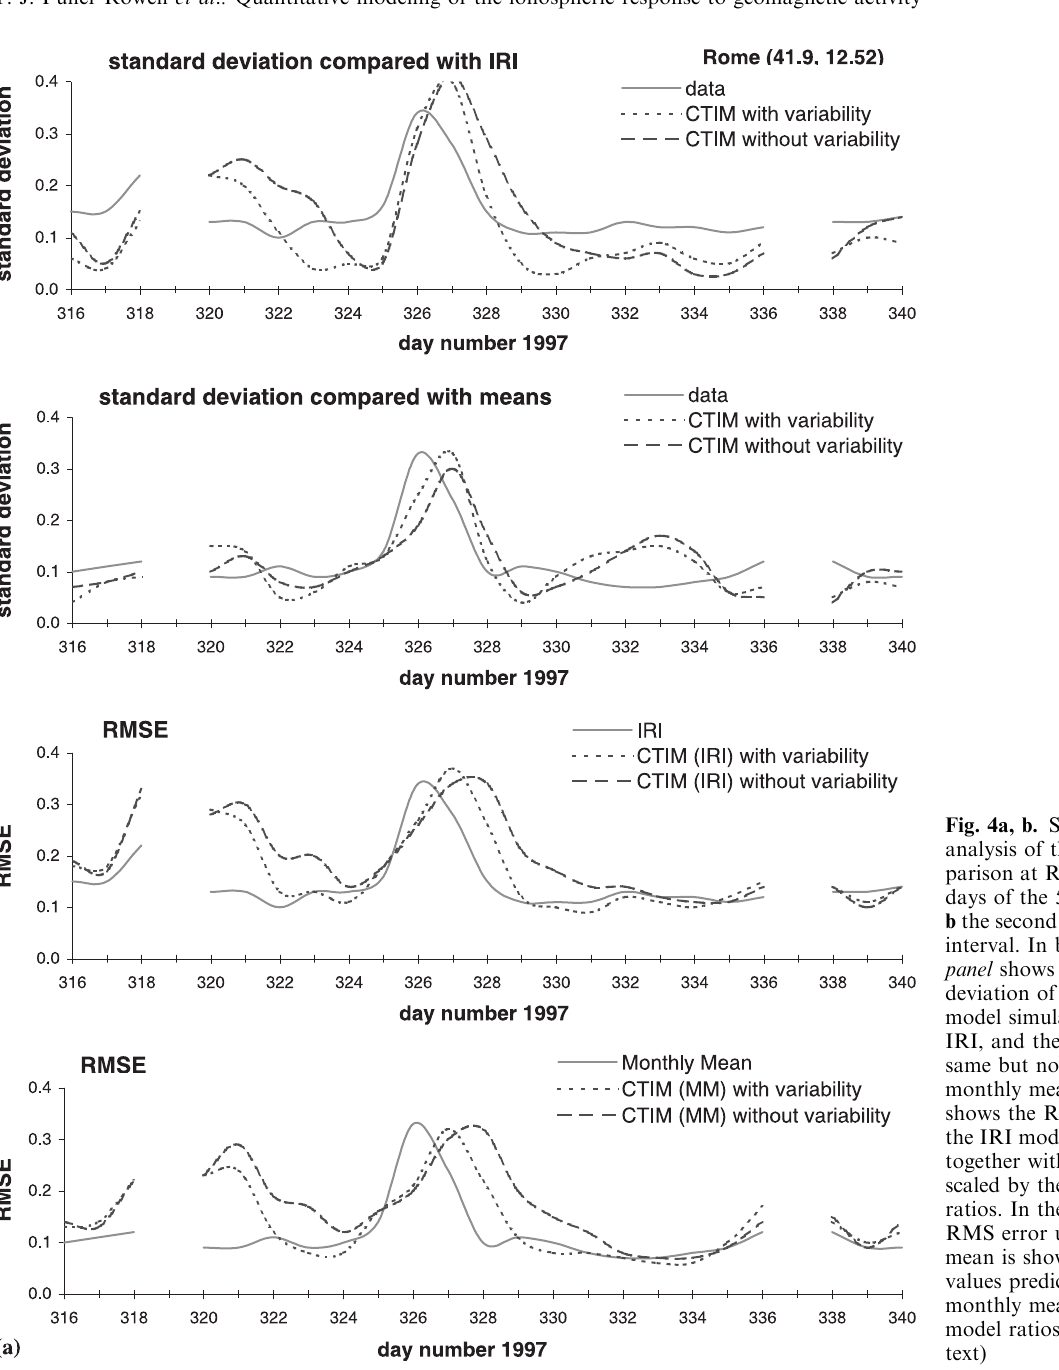
Fig. 4a, b. Summary of statistical analysis of the model/data com- parison at Rome for a the first 25 days of the 50-day interval, and b the second 25 days of the 50-day interval. In both cases, the top panel shows the daily standard deviation of the data and the two model simulations normalized by IRI, and the second panel is the same but normalized by the monthly mean. The third panel shows the RMS errors by using the IRI model to predict the data, together with the IRI values scaled by the model predicted ratios. In the fourth panel , the RMS error using the monthly mean is shown together with values predicted by scaling the monthly mean by the normalized model ratios (as explained in